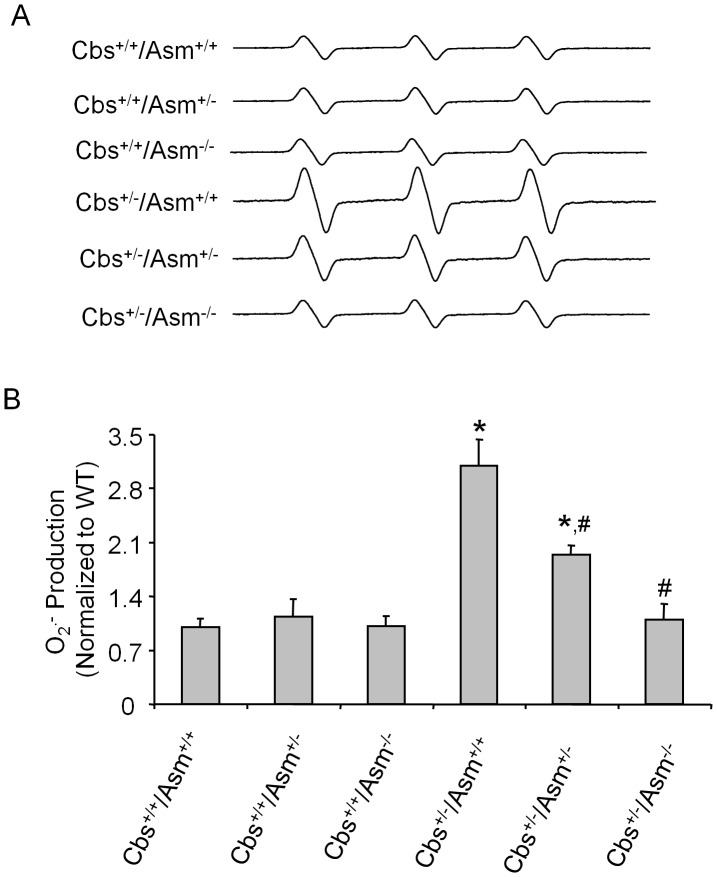
Glomerular O2.− production in Cbs+/+/Asm+/+, Cbs+/+/Asm+/−, Cbs+/+/Asm−/−, Cbs+/−/Asm+/+, Cbs+/−/Asm+/− and Cbs+/−/Asm−/− mice.A: Representative ESR spectra traces for O2.− production in 6 different groups of mice. B: Values are arithmetic means ± SEM (n = 5 each group) of O2.− production in Cbs+/+/Asm+/+, Cbs+/+/Asm+/−, Cbs+/+/Asm−/−, Cbs+/−/Asm+/+, Cbs+/−/Asm+/− and Cbs+/−/Asm−/−. * Significant difference (P<0.05) compared to the values from Cbs+/+/Asm+/+ mice; # Significant difference (P<0.05) compared to the values from Cbs+/−/Asm+/+ mice.